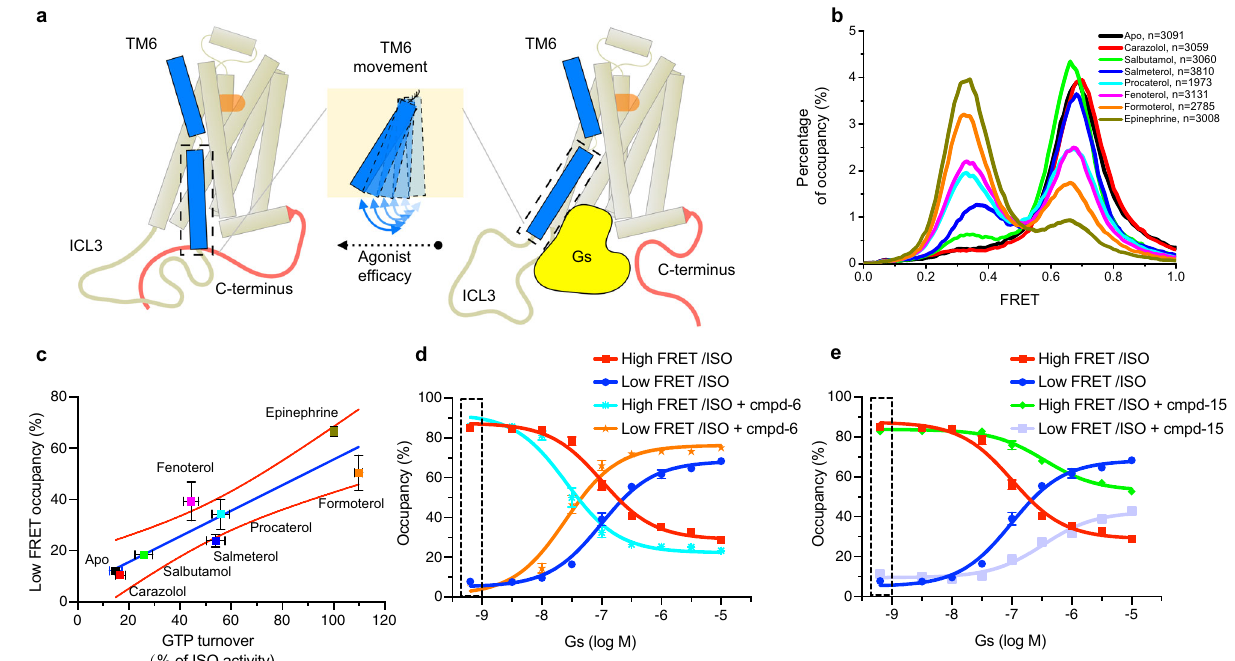
Fig. 3 | The effect of ligand ef fi cacy and GsGDP on CT dynamics. a A schematic modeloutlinesthe ligand ef fi cacy-dependentin fl uenceon the dynamicsof TM6.A hallmarkofGPCRactivationbydifferentagonistsisanoutwardmovementofTM6. Gs coupling requires disruption of interactions between the CT and the cyto- plasmic core of the β 2 AR. b Ligand ef fi cacy-dependent in fl uence on the smFRET ef fi ciencydistribution of 148C-378C. All experiments were done in the presenceof 10 μ M Gs GDP , and saturating concentrations of ligands. The stabilization of the low- FRETstate correlateswithagonistef fi cacy. c Thepositivecorrelationbetweenlow- FRET occupancy and ligand ef fi cacy (measured by a GTP turnover assay). The